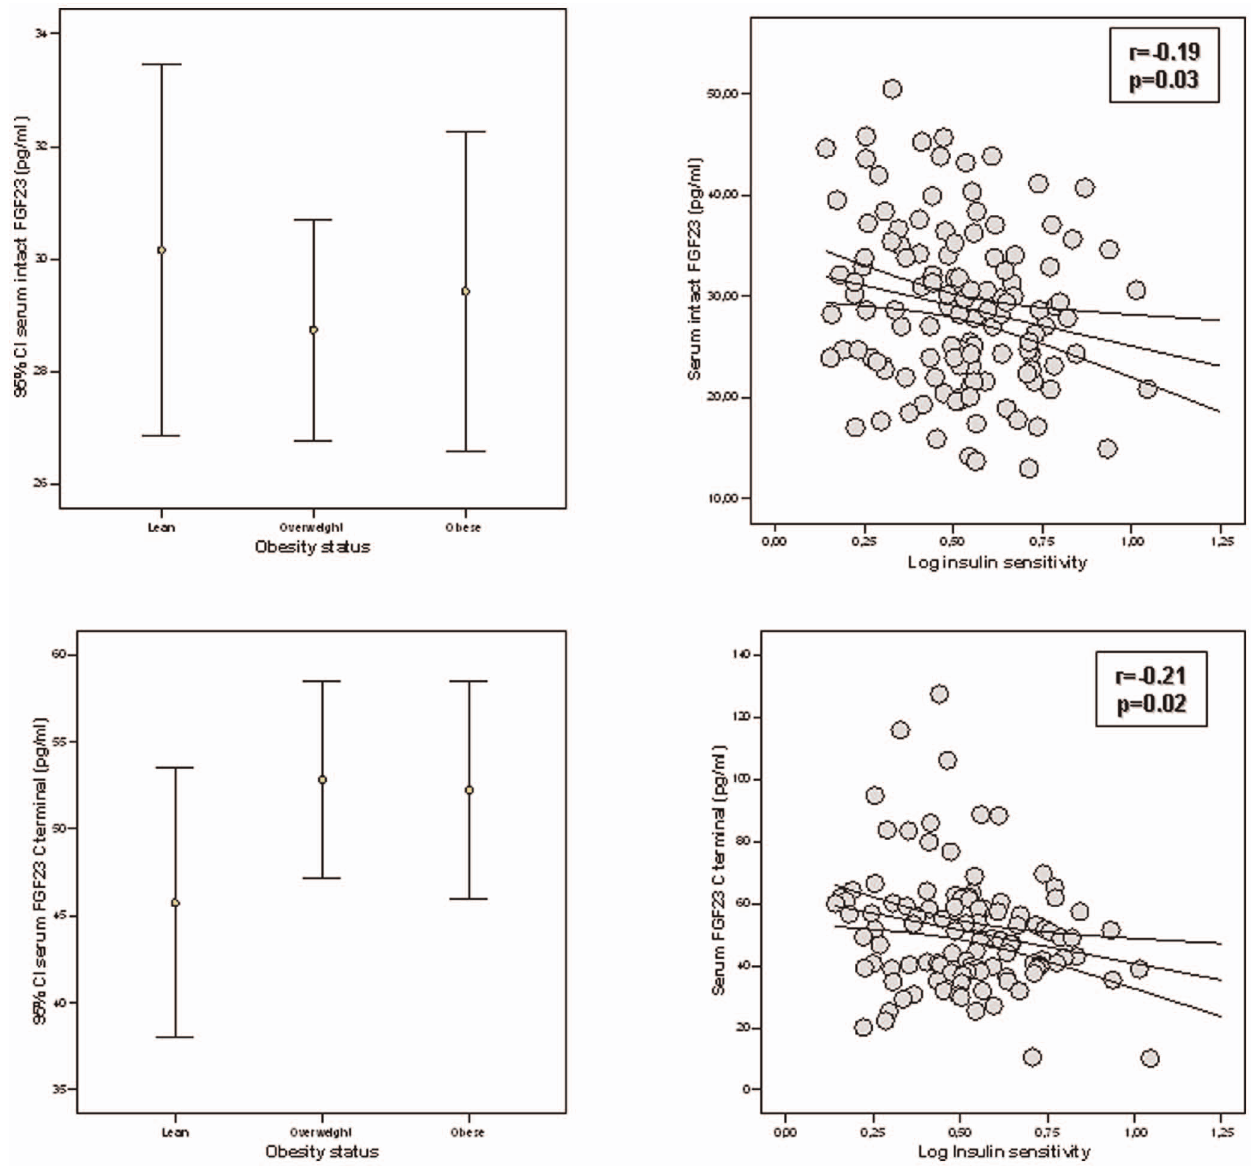
Figure 1. FGF-23 associations with obesity. a) Linear association analysis between serum intact FGF-23 concentrations and body mass index; b) serum intact FGF-23 concentration according to obesity status; c) Linear association analysis between serum C-terminal FGF-23 concentrations and body mass index; d) serum C-terminal FGF-23 concentration according to obesity status. All subjects from both cohort 1 and 2 are included.